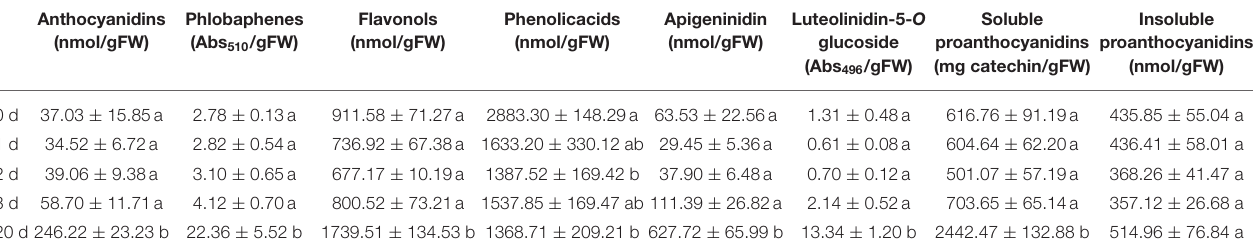
TABLE 2 | Polyphenols signature detected by spectrophotometric analyses in A. filiculoides challenged with 5 ◦ C and moderate light intensity (700 PPFD) for 20 days. Anthocyanidins